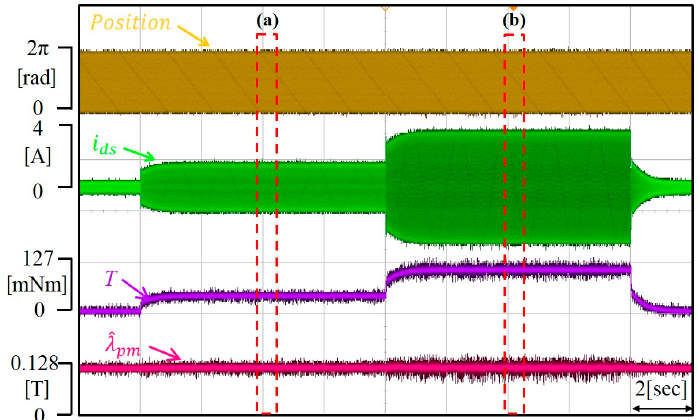
Figure 12. Characteristics of a SPMSM drive without applying the proposed algorithm (Operating condition: ω r = 620 rad/s, permanent magnet temperature = 25 °C).